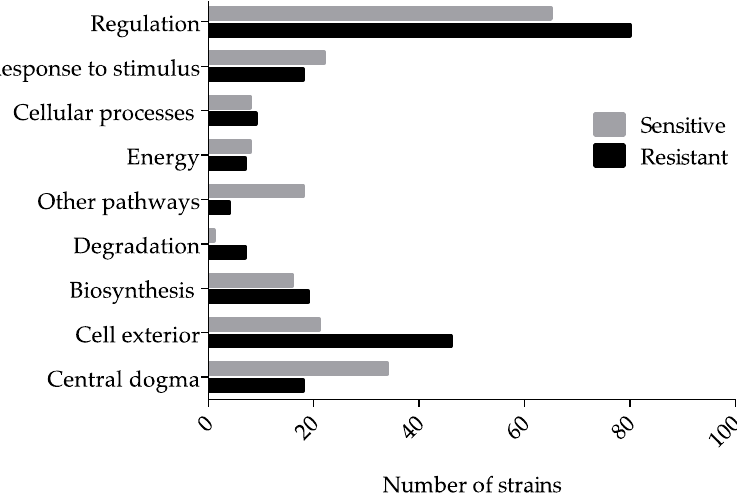
Figure 2. Ga-resistant and -sensitive gene hits mapped to component cellular processes. Several gene hits are mapped to more than one subsystem. The cutoff fitness score selected was two standard deviations from the mean and recovered gene hits with a score outside this range were chosen for further analyses. The hits were mined using the Omics Dashboard (Pathway Tools), which surveys against the EcoCyc database. Each individual score represents the mean of 9–12 trials.